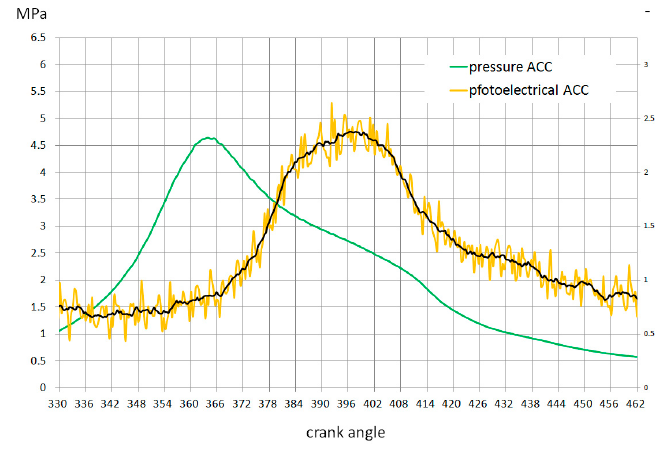
Figure 20. The change in indicated pressure and radiation intensity recorded by the phototransistor.